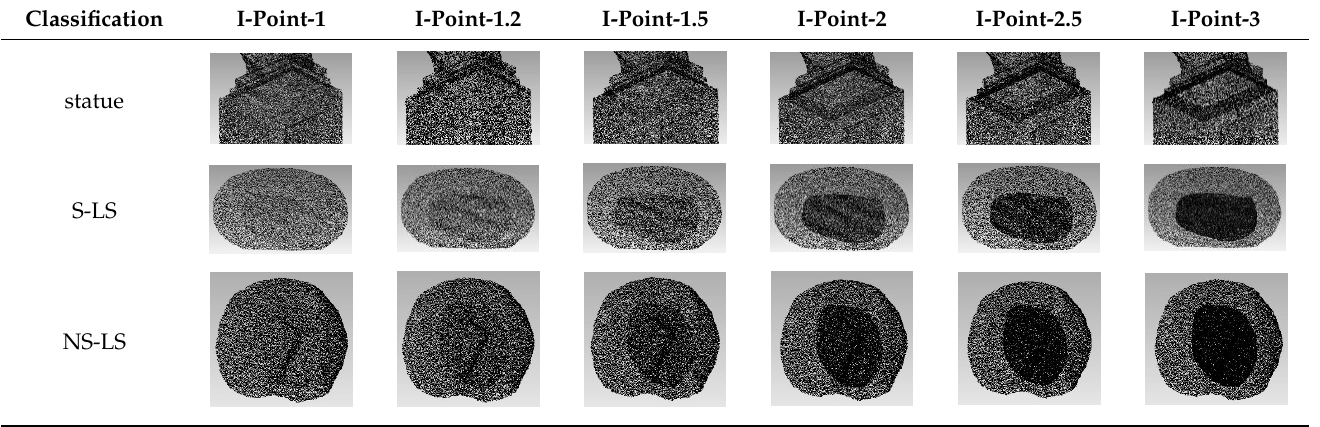
Table 3. The registration results of two kinds of data.